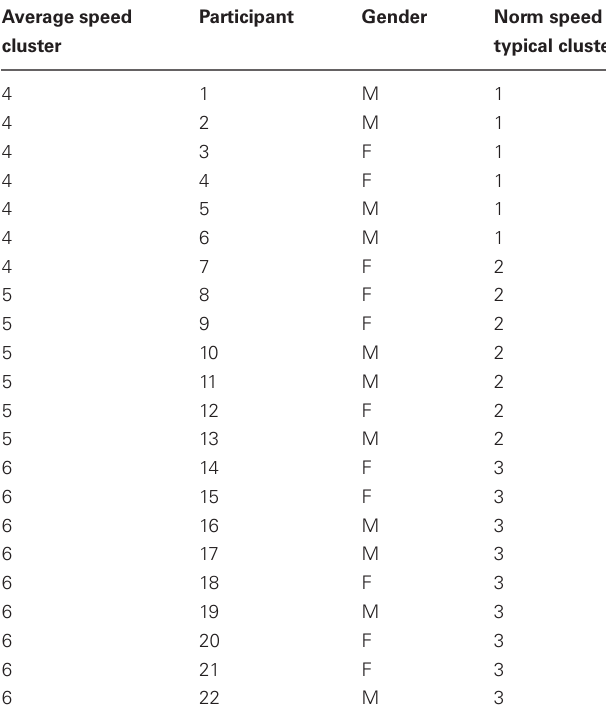
Table A2 | Information from TD participants. Table A3 | Information from College-Level TD